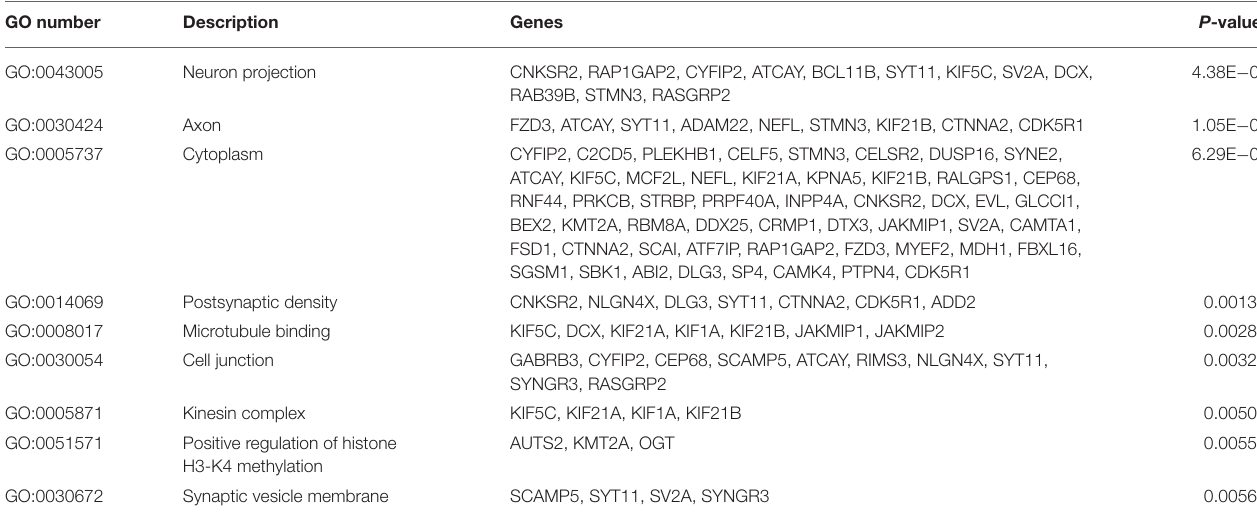
TABLE 3 | Gene ontology analysis of lncRNA MIAT-related